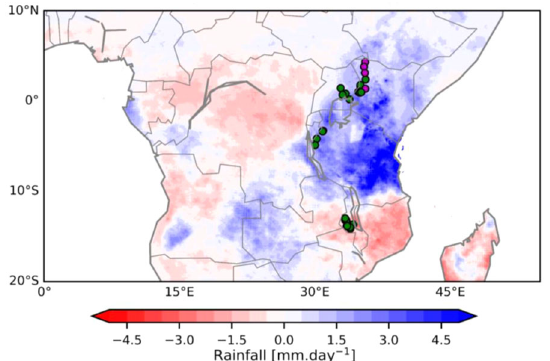
Fig. 1 Analysis of rainfall anomalies during the period from January to April 2020 against 1983 – 2012 climatology indicates unusually high rainfall in Kenya, Uganda, and Tanzania and low levels of rainfall in Malawi. Green dots indicate locations of piped schemes where the PAYF payment modality is employed. Magenta dots indicate locations of piped schemes where the monthly fee payment modality is employed.